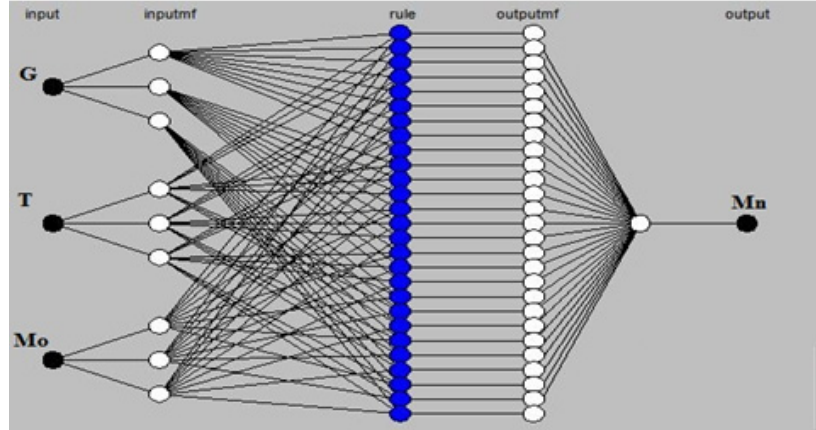
Figure 4. The Adaptive Neuro-Fuzzy Inference System model’s construction.